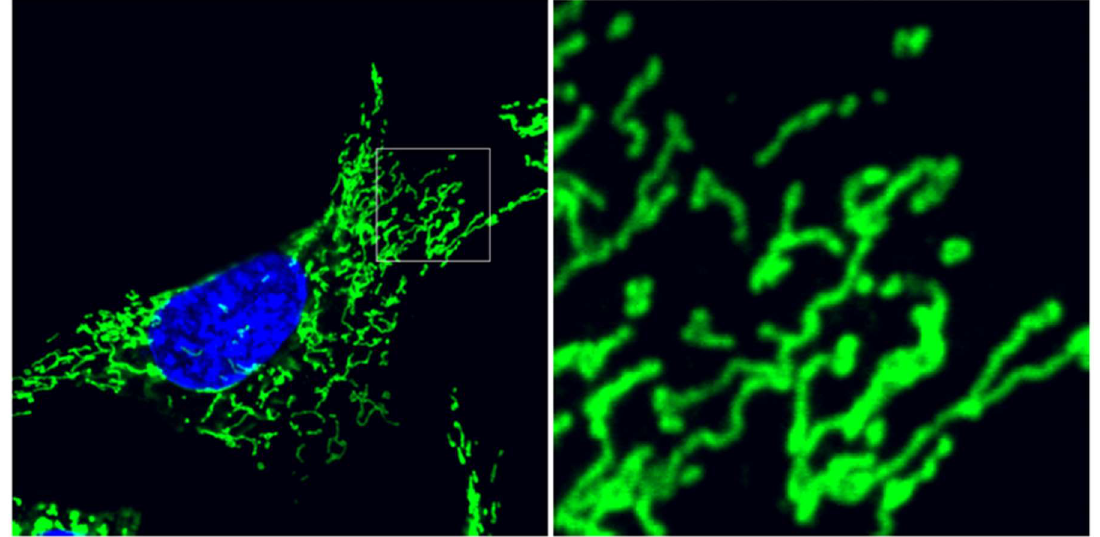
Figure 1. Mitochondrial ultrastructure balances between interconnection and division. Mouse embryonic fibroblasts immunolabeled for mitochondrial translocase of the outer membrane 20 (TOM20) outer membrane protein (green) and counterstained with diaminophenylindole (DAPI) (blue) for nuclei. Detail image depicts the pleiomorphic balance of isolated, spherical organelles and interconnected reticular mitochondria. Cellular stress induces remodeling of mitochondrial fusion and fission dynamics, controlled by overlapping activity with m -AAA protease 1 (OMA1) and dynamin-related protein 1 (DRP1), respectively.